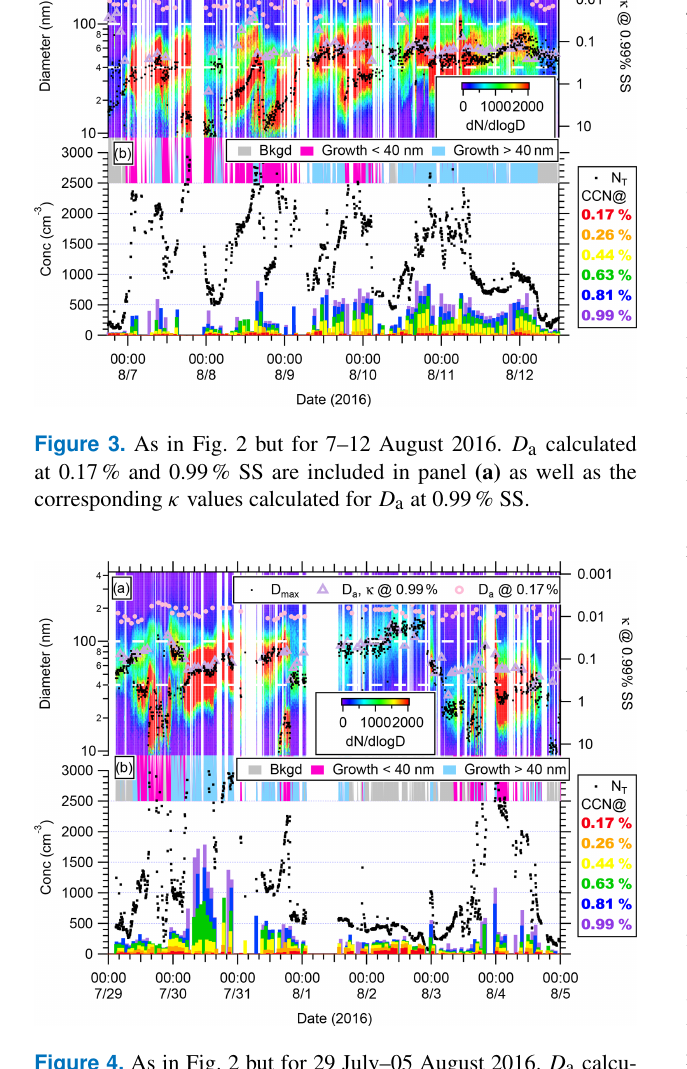
Figure 4. As in Fig. 2 but for 29 July–05 August 2016. D a calcu- lated at 0.17% and 0.99% SS are included in panel (a) as well as the corresponding κ values calculated for D a at 0.99%